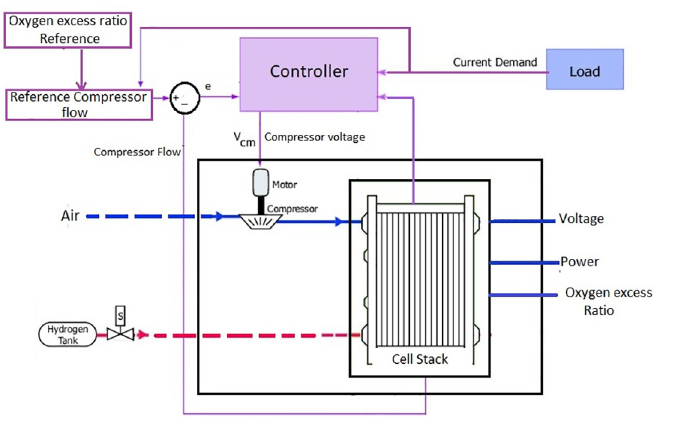
Fig 4. Air delivery system of